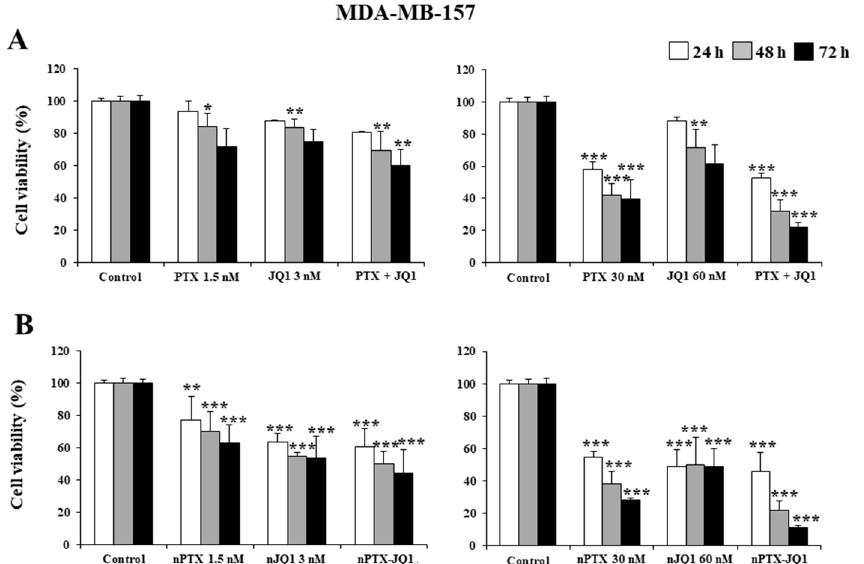
Figure 4. Effects of JQ1 and PTX on TNBC cell viability. MDA-MB-157 cells were treated with JQ1 and PTX in the free form ( A ) or encapsulated in zein nanoparticles ( B ) as single agents (nJQ1, nPTX) or as multidrug carriers (nJQ1-PTX). Each experiment was performed in triplicate and values are expressed in % over untreated cells (control), as mean ± SD. Statistical analysis was performed using the Tukey–Kramer multiple comparisons test. * p < 0.05, ** p < 0.01, *** p < 0.001 vs. control.